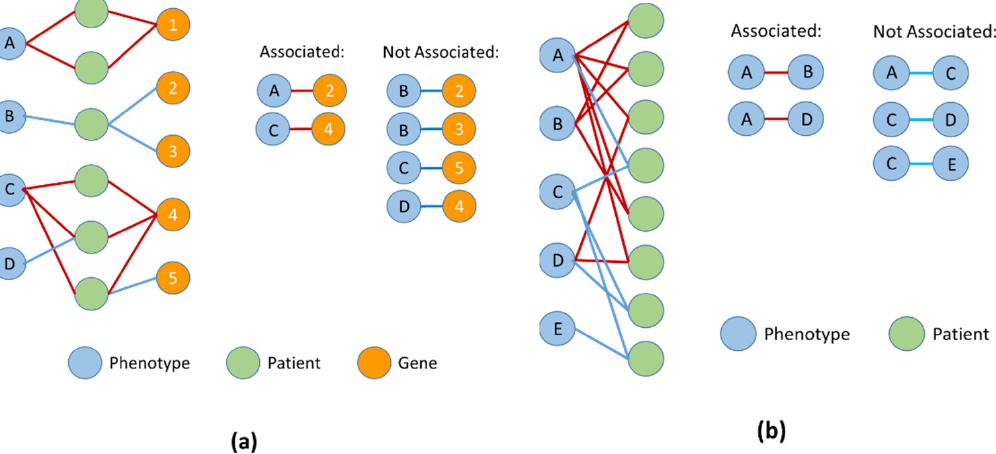
Figure 2. Overview of the use of multipartite networks to obtain phenotype–gene and phenotype– phenotype associations. ( a ) A phenotype–patient–gene tripartite network is constructed from patient data, such that a given phenotype in the cohort is linked to a gene in the cohort when there is at least one patient in the cohort who both manifests the phenotype and has a mutation that maps to the gene. Once the network has been built, it can be analysed to find those phenotype–gene pairs that are highly and specifically connected over many patients, using a statistical test to determine whether there is evidence that the pair is associated. There is also a third set of phenotype gene pairs, which are not connected via any patient (e.g., A-2), these are also considered not to be associated. ( b ) A phenotype–patient bipartite network is constructed from patient data, such that phenotypes are connected to patients when there is at least one patient in the cohort manifesting the phenotype. Once built, the network can be analysed to find pairs of associated phenotypes that are connected by many patients in a specific manner, using a statistical test. As with the phenotype–gene pairs, there are phenotype–phenotype pairs that are not connected by any patient (e.g., B–C). These must also be considered not